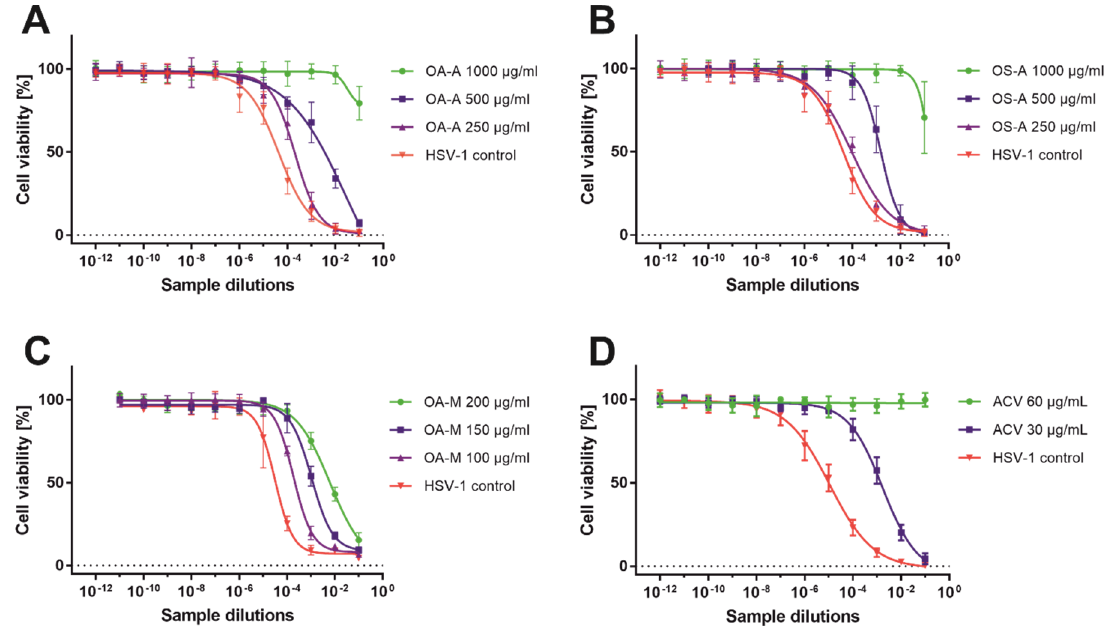
Figure 3. The HSV-1 titration assay of selected samples.